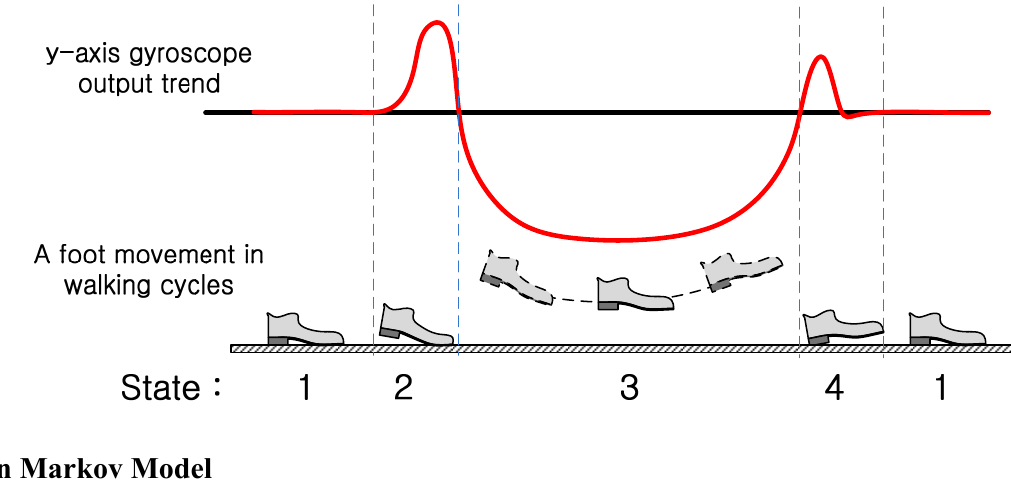
Figure 3. y -axis gyroscope value trend and a foot movement in normal walking cycles.